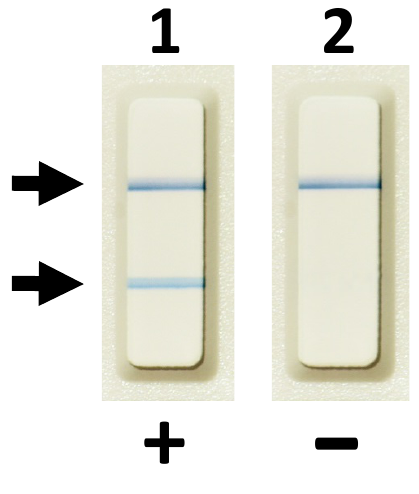
Figure 2. Oral fluid (saliva, mouth rinse, gingival crevicular fluid (GCF), and peri-implant sulcular fluid (PISF)) lateral flow aMMP-8 point-of-care / chair-side immunoassay. Lane 1, two lines indicate aMMP-8 levels > 20 ng / mL in GCF and a risk of progressive and active peri-implantitis before